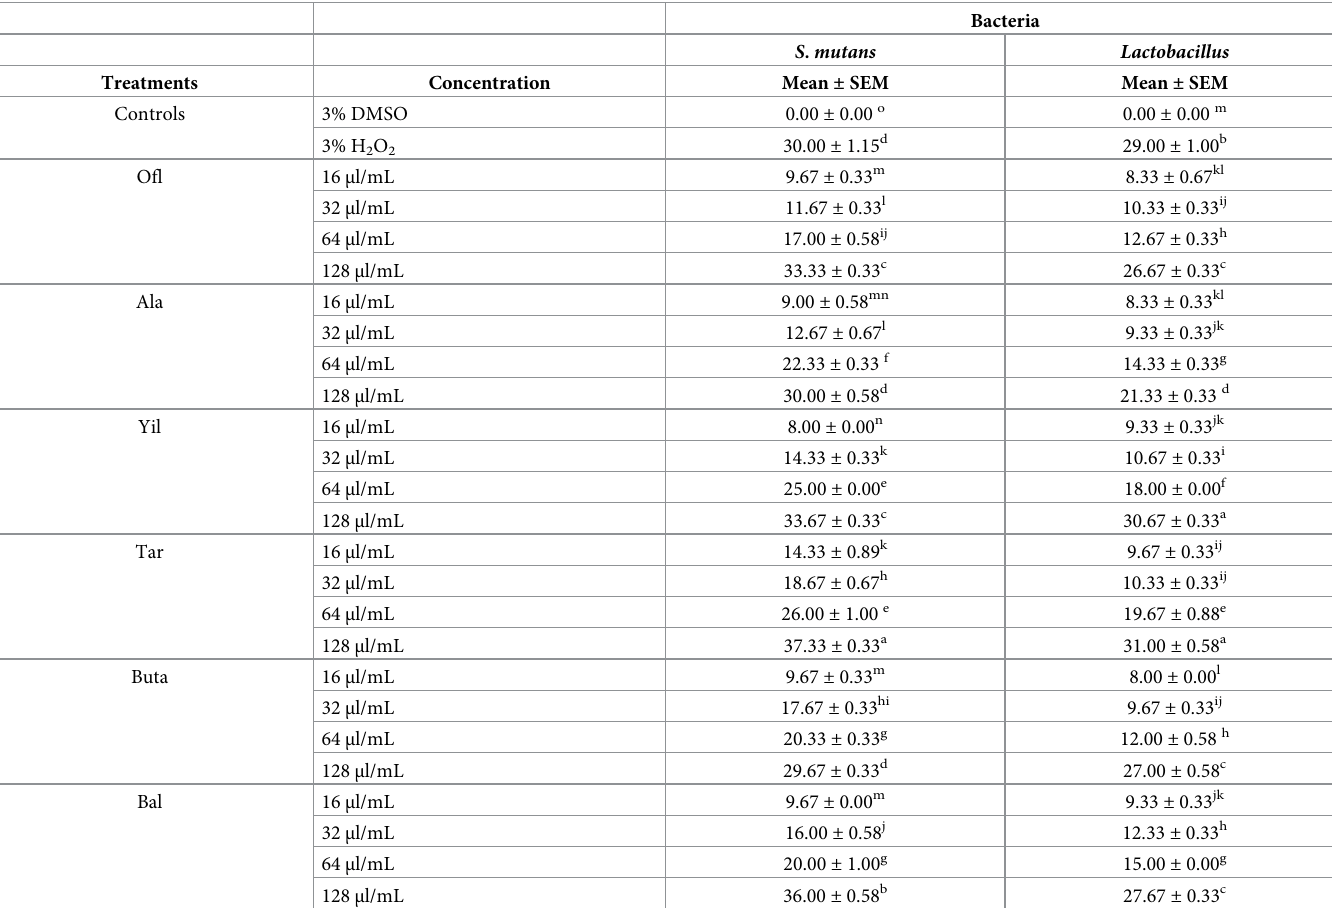
Table 2. Antibacterial activity of the EOs of Ofl, Ala, Yil, Tar, Buta, and Bal using agar disc diffusion method compared to the negative and positive controls (mean ± SEM for three repetitions) � .